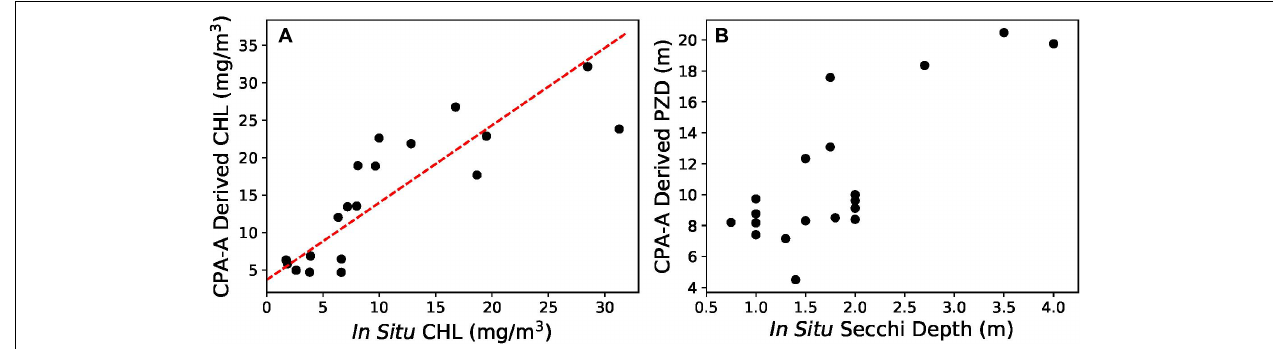
FIGURE 2 | Comparisons between remote sensing estimates and in situ measurements in 2020. Panel (A) shows a comparison between remotely sensed and in situ chlorophyll- a (CHL), with the type II regression best fit line displayed in red ( y = 3.67 + 1.03 × x ; R 2 = 0.66; p < 0.01). Panel (B) shows the comparison between remotely sensed photic zone depth (PZD) and in situ Secchi disk depth.